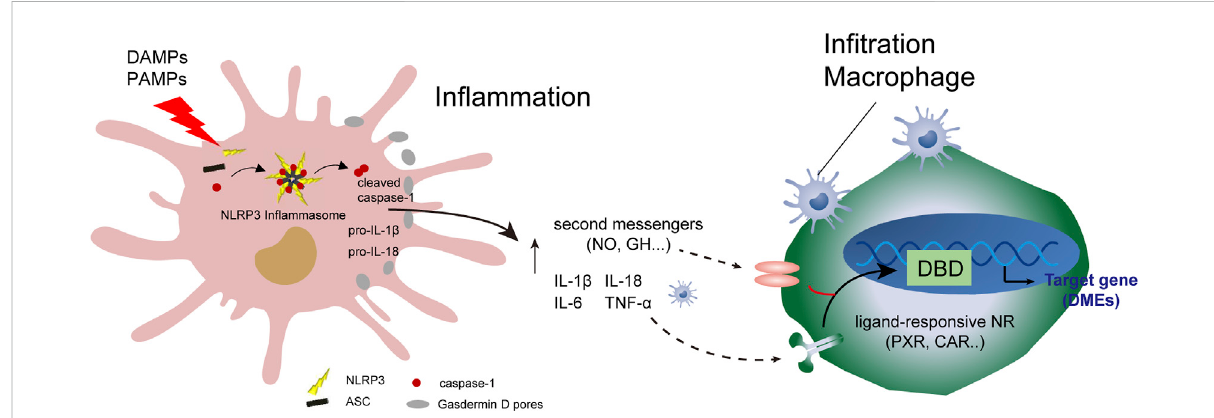
FIGURE 3 Programmedinjuryofhepatocytesandregulationofcytochrome450enzymes.Crosstalkoccursbetweenparenchymalandnon-parenchymal cells during hepatocytic in fl ammation. DAMPs, damage-associated molecular patterns; DBD, DNA-binding